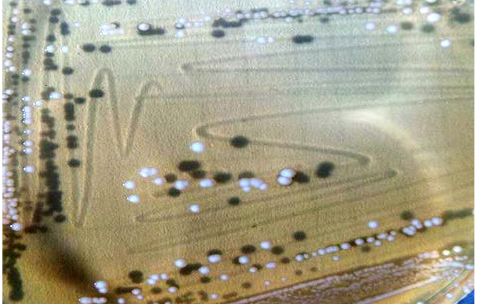
A: Culture of Pediococci on the medium M17 agar B: Culture of Streptococcus on M17 agar medium